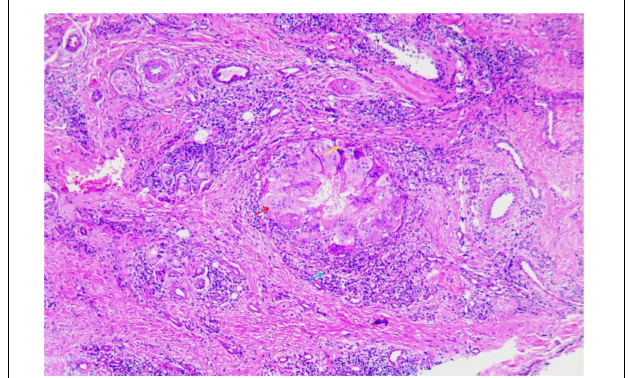
FIGURE 2 | Biopsy of the lesion showed dense infiltration of multinuclear giant cells (red arrow), histiocytes (yellow arrow), and lymphocytes (blue arrow) in the dermis (hematoxylin and eosin stain, × 400).